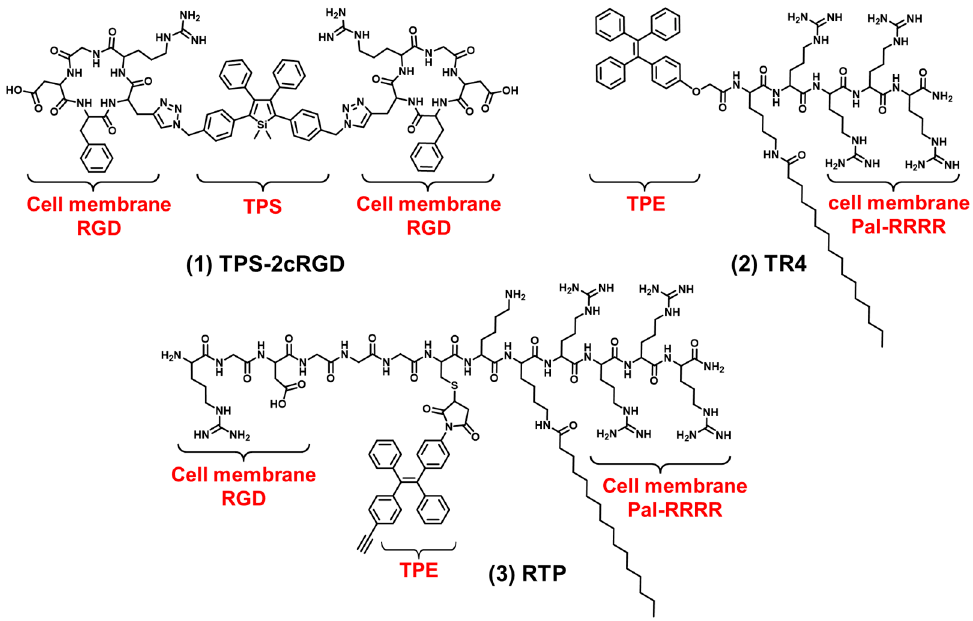
Figure 2 . The chemical structures of cell membrane-targeting bioprobes. Figure 2. The chemical structures of cell membrane-targeting